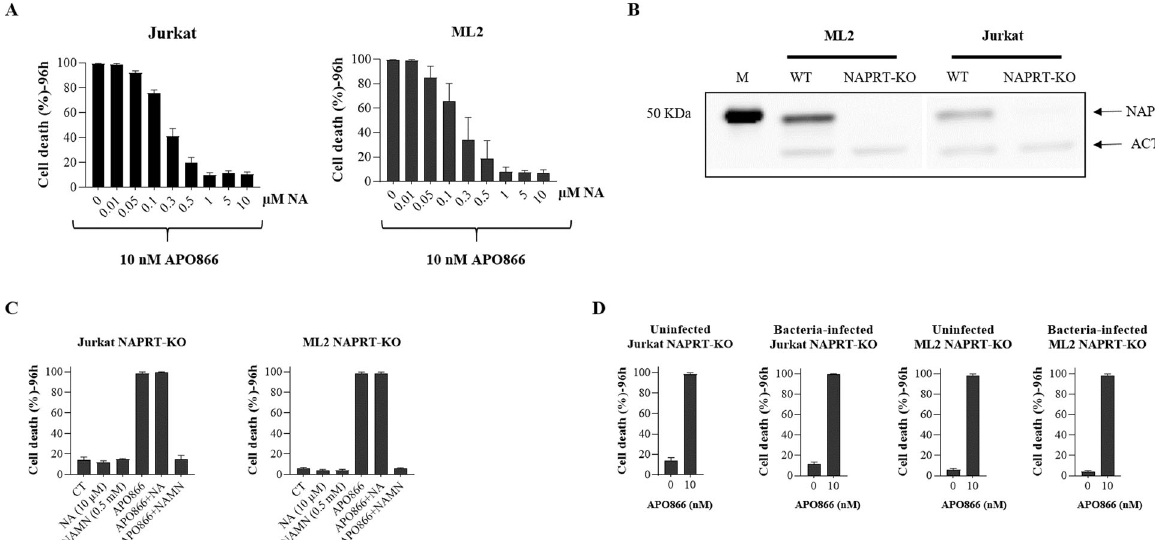
Fig. 4 The abrogation of the anti-leukemic effect of APO866 in bacteria-infected leukemic cells requires the integrity of NAPRT. A ML-2 or Jurkat cells were incubated with or without various concentration of NA in presence of 10 nM APO866 for 96 h and cell death was assessed as described in Fig. 1. B NAPRT was knocked-out in wild type ML-2 and Jurkat cells using CRISPR/Cas9 technology; loss of expression was con fi rmed by Western blotting. C Jurkat NAPRT-KO and ML2 NAPRT-KO cells were pre-incubated with or without NA (10 µM) or NAMN (0.5 mM) before exposure to 10 nM APO866 for 96 h and cell death was assessed as described in Fig. 1. D Uninfected and bacteria-infected Jurkat/ML2 NAPRT-KO cells were treated without or with 10 nM APO866 and cell death monitored as described in Fig. 1. Data are derived from at least three independent experiments, and they are shown as mean ± SD.